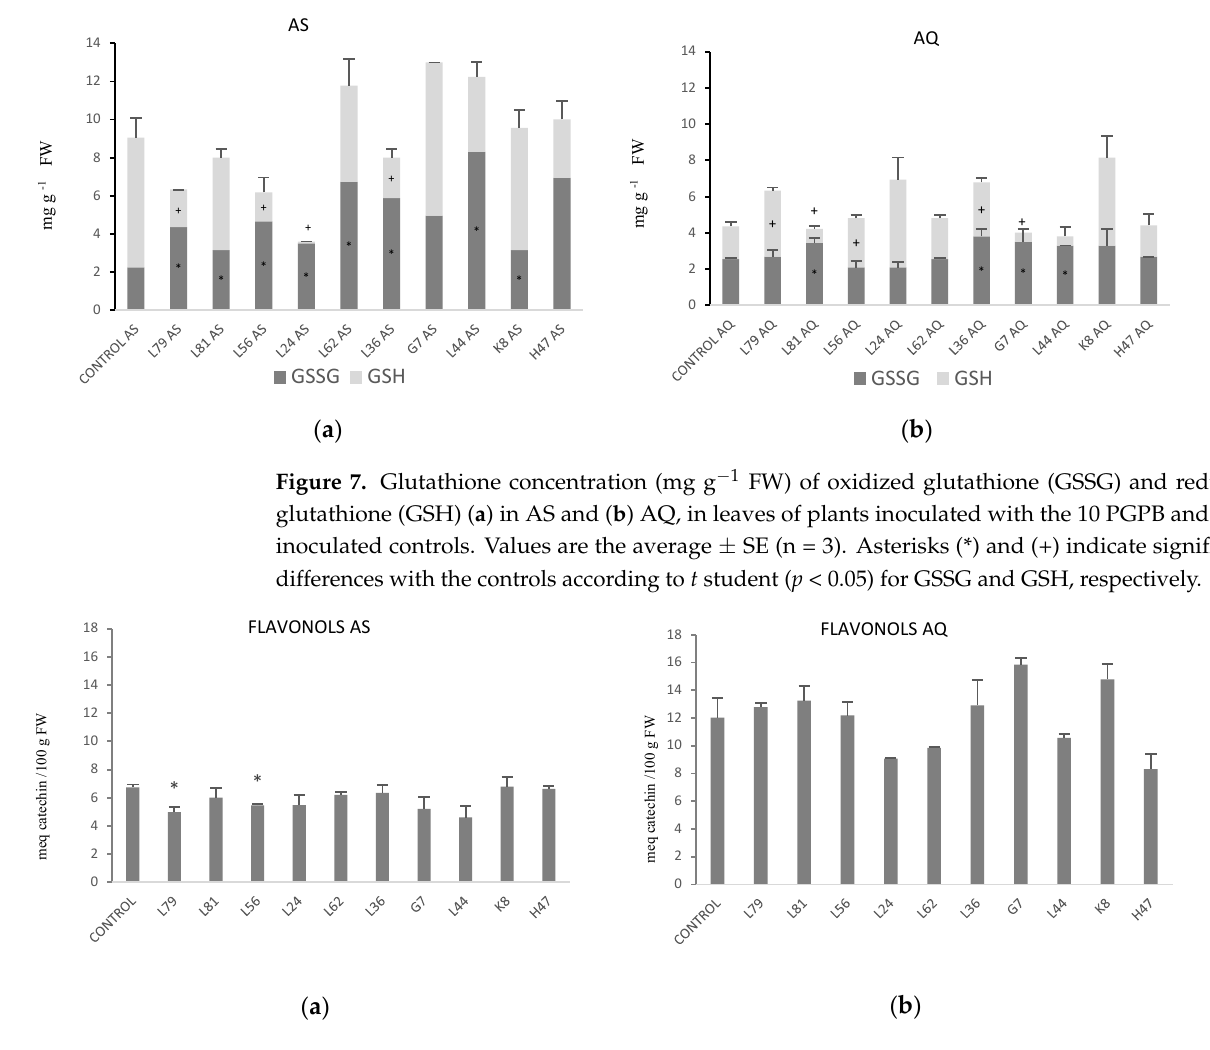
Figure 8. Flavonol concentration (meq catechin/100 g fresh weight) in ( a ) AS and ( b ) AQ leaves of plants inoculated with the 10 PGPB and non-inoculated controls. Values are the average ± SE (n = 3). Asterisks (*) indicate significant differences with the controls according to t student ( p < 0.05). As regards to the antioxidant molecules phenols and flavonols, phenols were